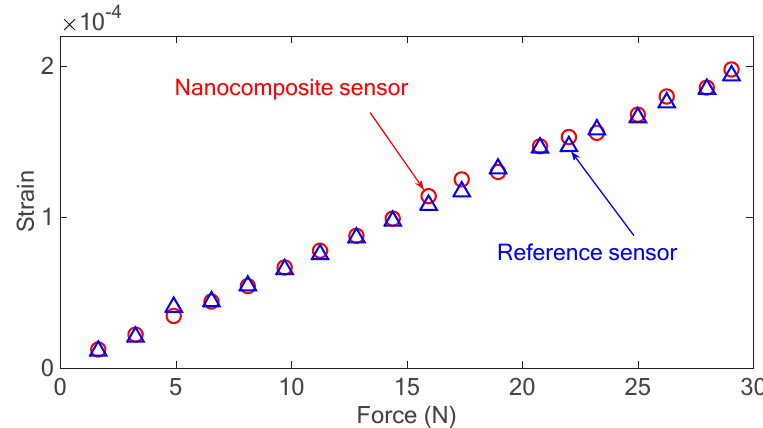
Figure 19. The strain of the beam under different excitation loads measured with both developed nanocomposite and metal foil strain gauge as reference sensor.